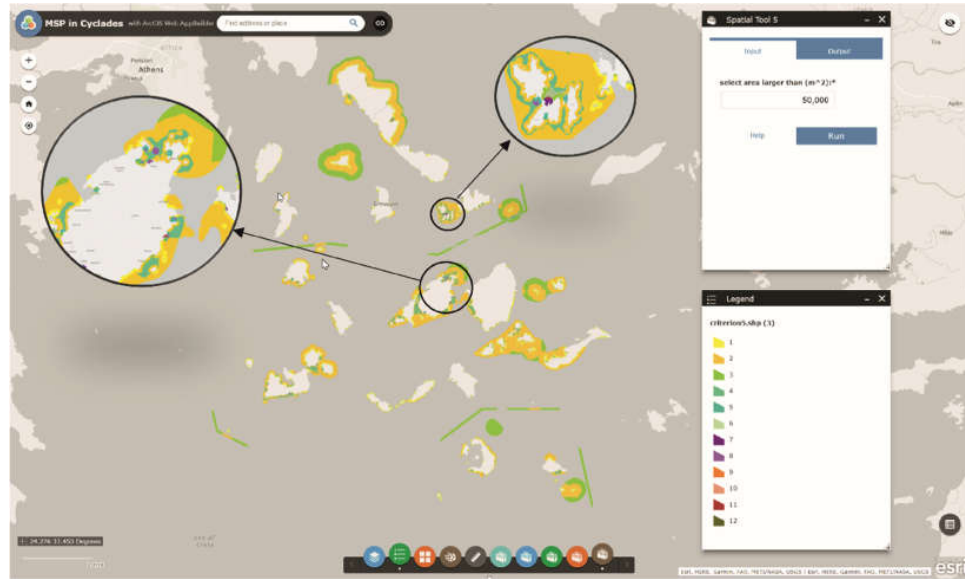
Figure 7. Areas of conflicts that are larger than 50,000 m 2 . Table 2. Extent of the areas where conflicts were detected using GP tools 2, 4, and